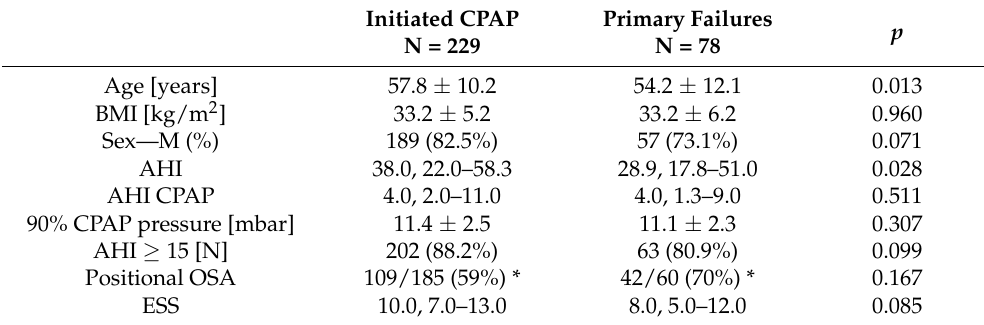
Table 3. Demographic and clinical characteristics of patients who initiated CPAP and primary failures.